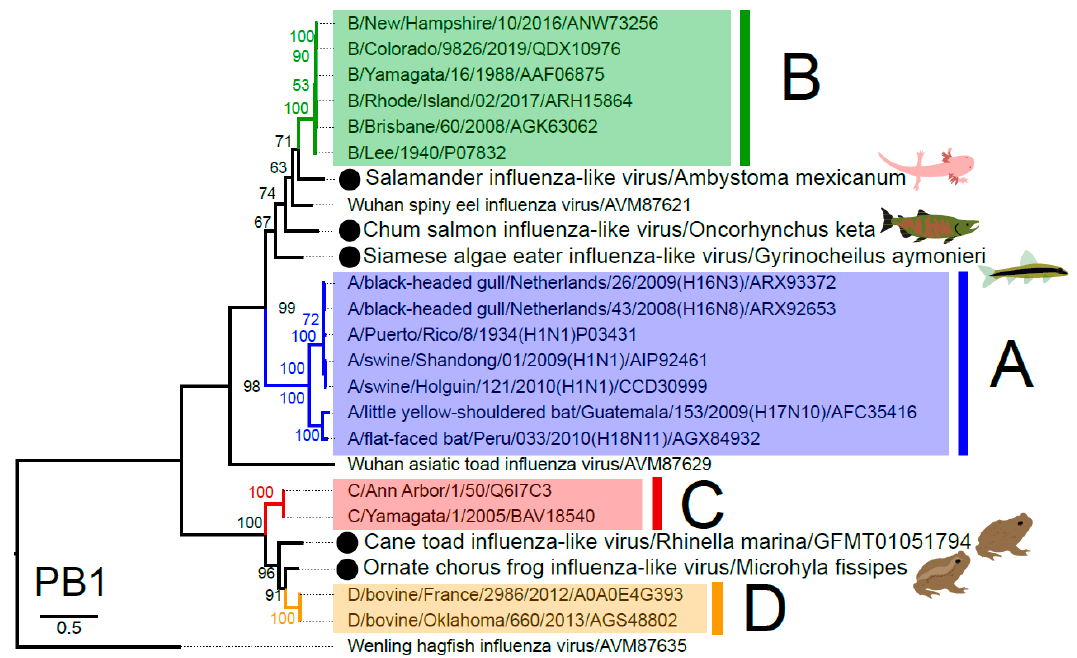
Figure 2. Phylogenetic relationships of vertebrate influenza-like viruses. Maximum likelihood tree of the PB1 segment, which encodes the RNA-dependent RNA polymerase, of various influenza-like viruses. Lineages corresponding to IAV, IBV, ICV, IDV are coloured blue, green, red and orange, respectively. Viruses identified in this study are denoted by a black circle and pictogram of the host species of the library. Wenling hagfish influenza virus is set as the outgroup as per Shi et al. [3]. The scale bar indicates the number of amino acid substitutions per site. Animal figures were created by M. Wille